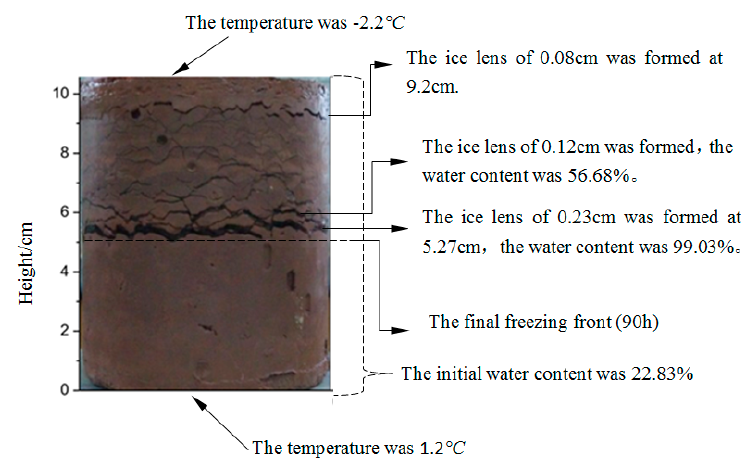
Figure 1. State of the sample after 90 h [20].